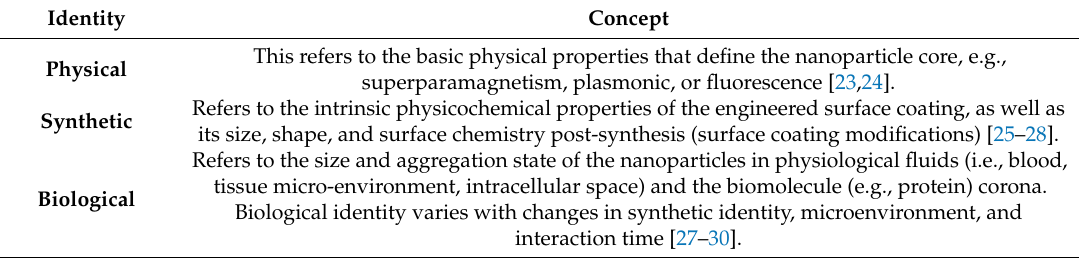
Table 1. Nanoparticle identities and their